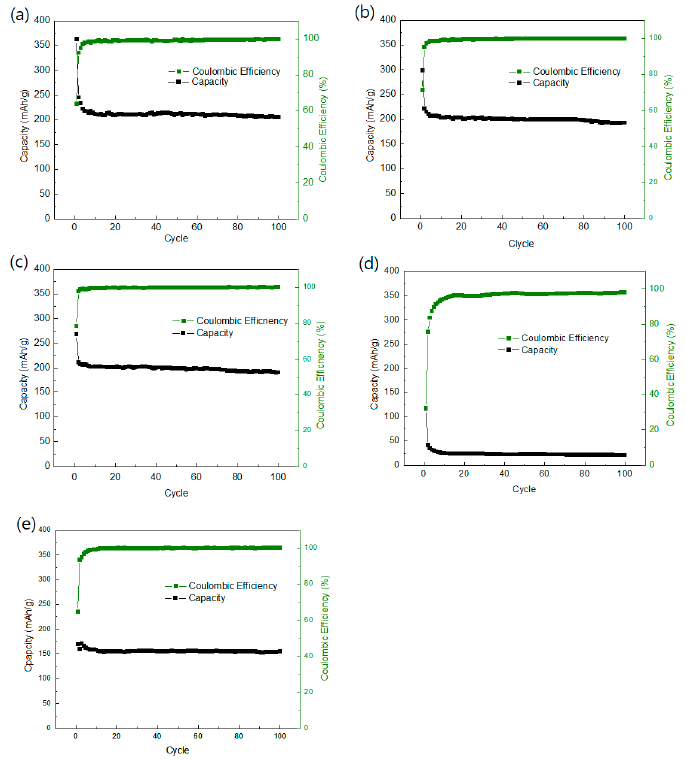
Figure 6. Capacity and coulombic efficiency curve of the ( a ) LC40 film, ( b ) LC50 film, ( c ) LC60 film, ( d ) buckypaper, and ( e ) LTO_Cu electrode at 1 C in the voltage window of 1–3 V (vs. Li + /Li).